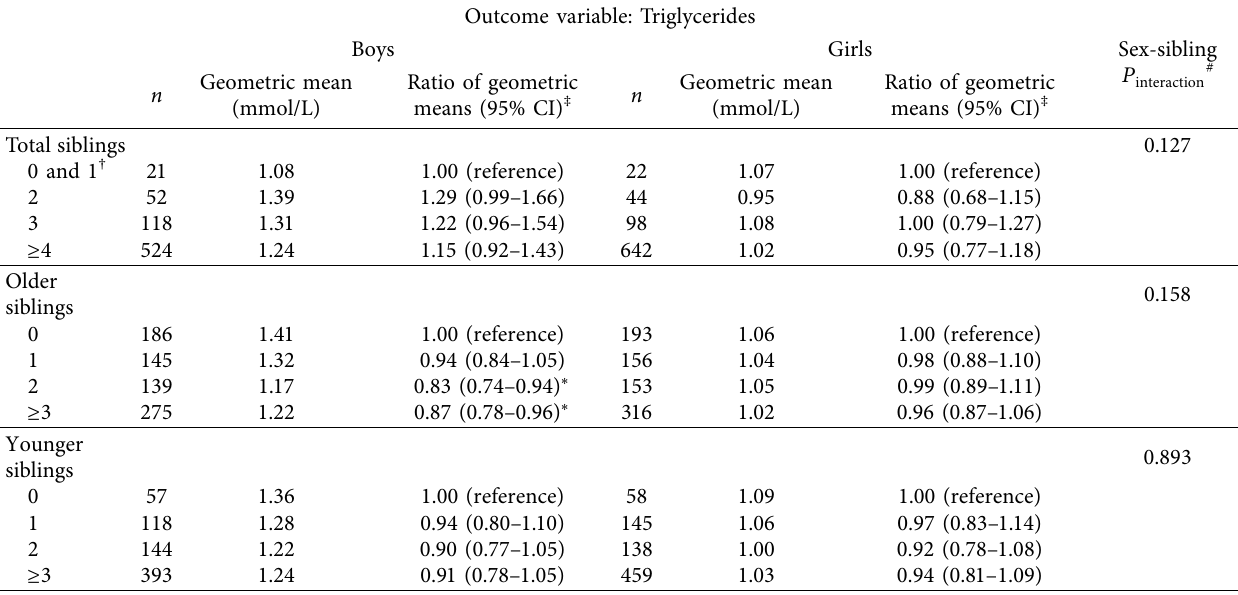
Table 5: Geometric means and adjusted ratio of geometric means of triglycerides according to the total number of siblings, number of older siblings, and number of younger siblings stratified by